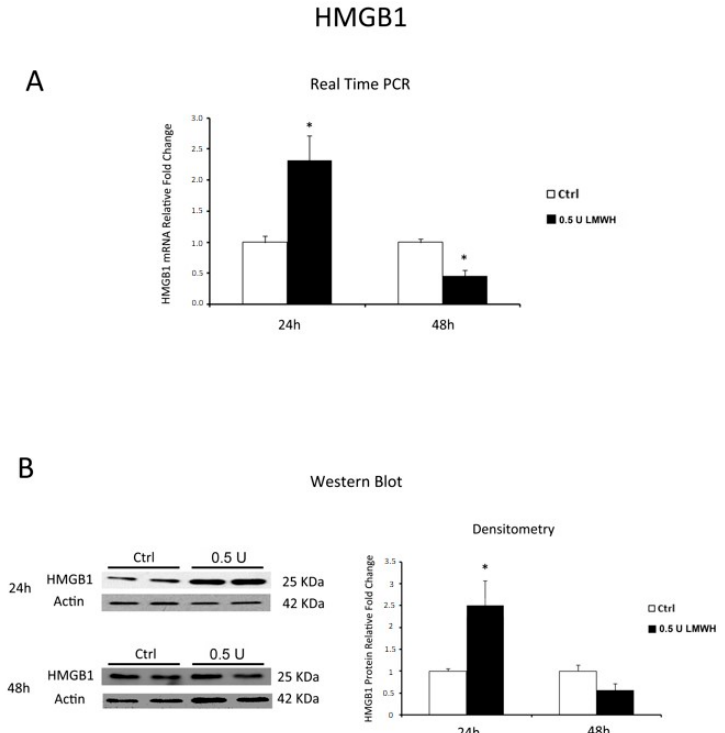
Figure 2. HMGB1 expression in LMWH-treated vs. untreated physiological placental villous explants. ( A ) HMGB1 mRNA expression levels in placental villous explants treated for 24 h (ctrl n = 8 and 0.5 U LMWH n = 10) and 48 h (ctrl n = 11 and 0.5 U LMWH n = 10) by 0.5 U of LMWH or plain culture medium, assessed by Real Time PCR; ( B ) Representative western blot for HMGB1 protein expression in LMWH-treated vs. untreated placental villous explants for 24 h (ctrl n = 4 and 0.5 U LMWH n = 4) and 48 h (ctrl n = 10 and 0.5 U LMWH n = 10). Statistical significance (*) has been considered as p < 0.05.